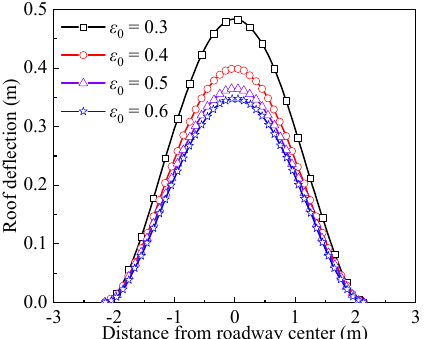
Figure 12. Relationship between composite roof deflection and scale parameter. It can be seen from Figure 12 that when the scale parameter ε 0 = 0.3, the maximum deflection of mudstone stratification is 0.484 m; when the scale parameter increases to 0.4, the maximum deflection of mudstone stratification decreases sharply to 0.399 m; with the continuous increase in scale parameter, the maximum deflection of mudstone